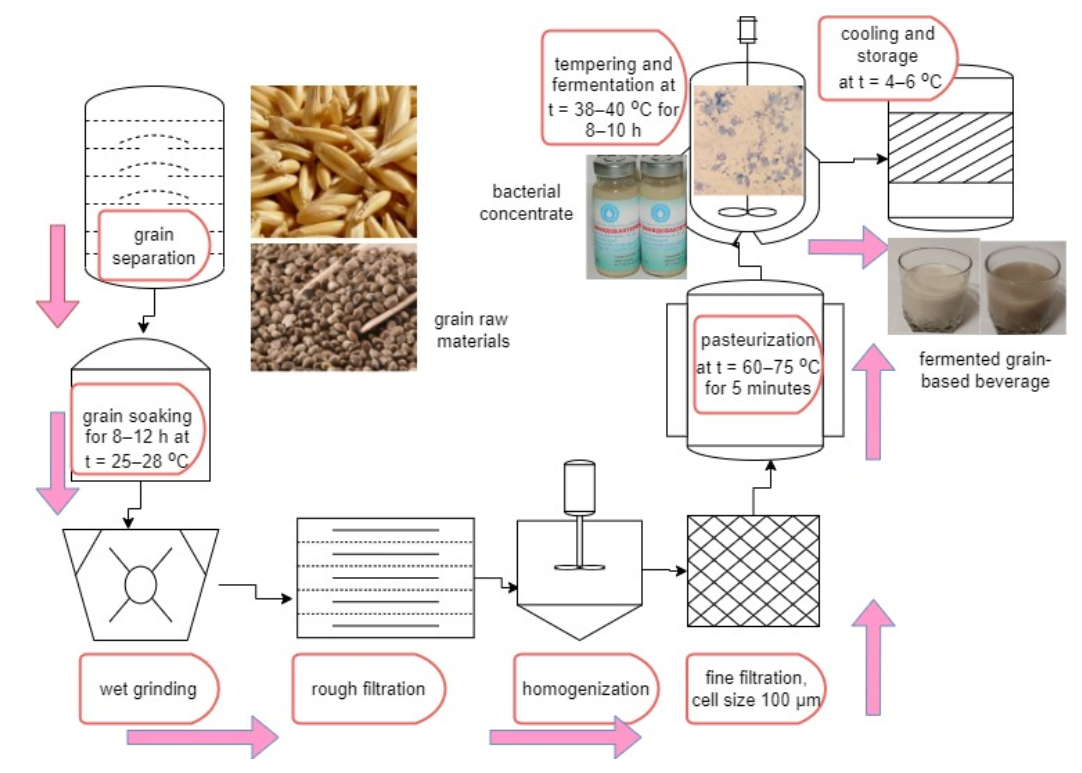
Figure 1. The production stages of the fermented grain-based beverages. Table 1. The component composition of the beverage samples.